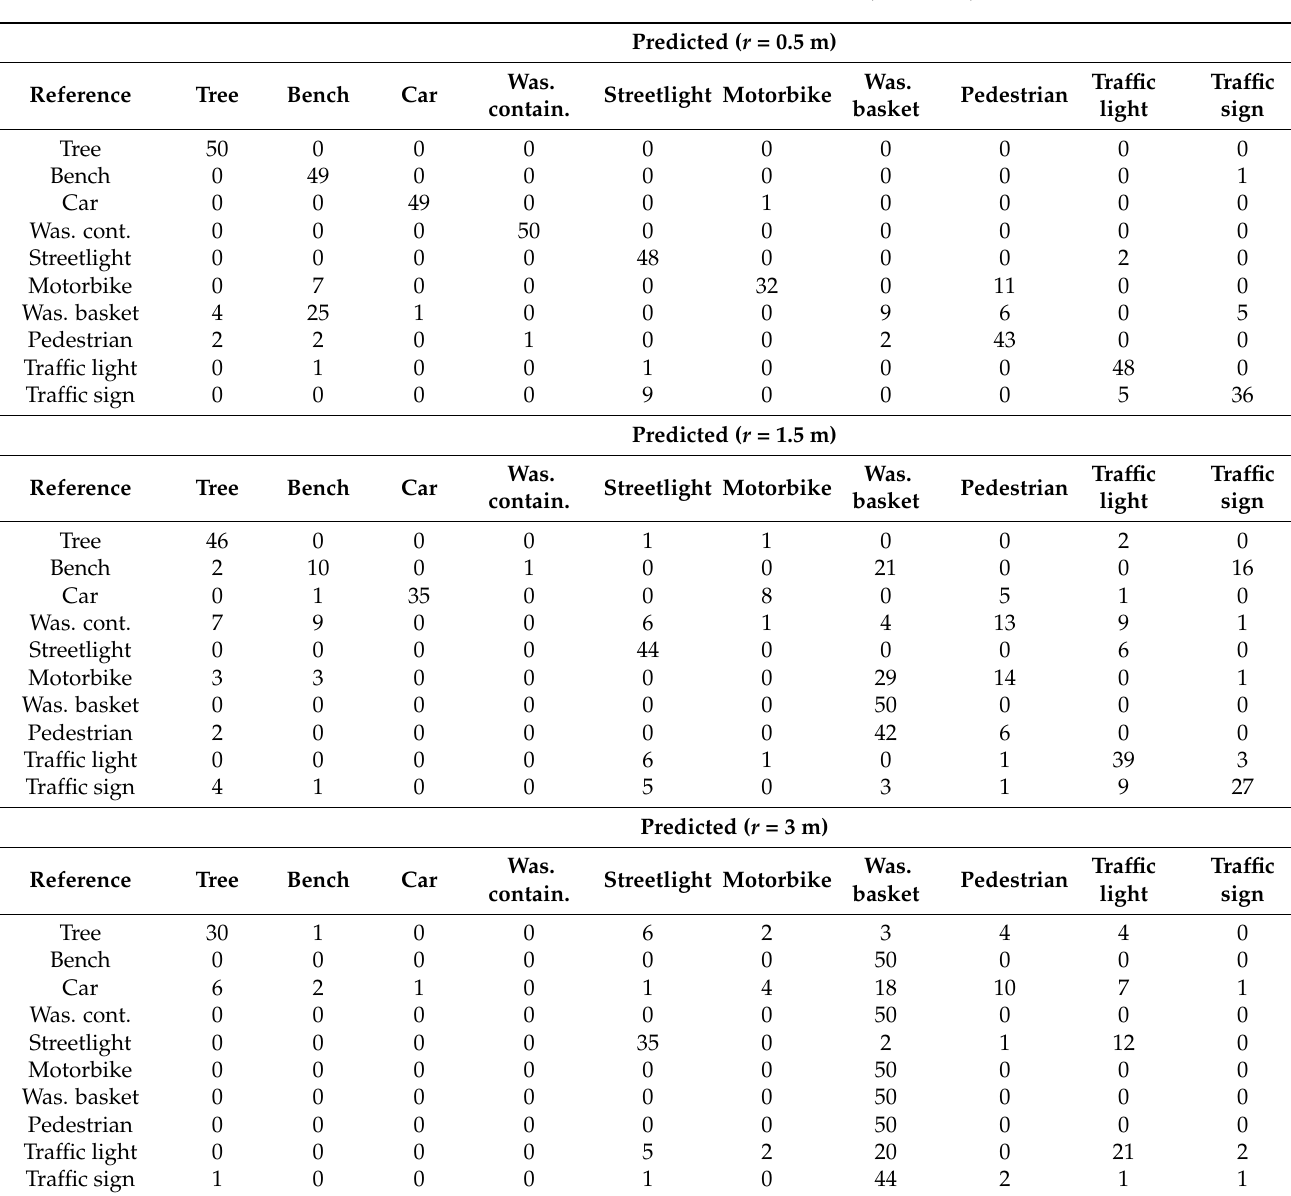
Table 11. Confusion matrices for occlusion evaluation with r = 0.5 m, r = 1.5 m, and r = 3